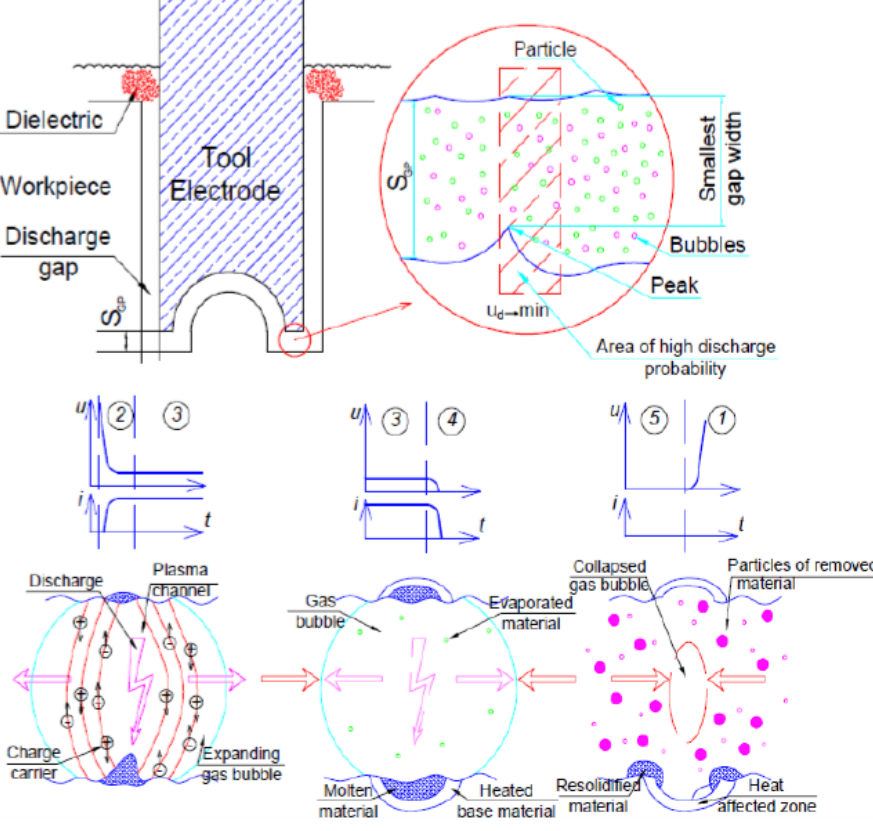
Figure 3. The pulse occurring through the electrical discharge machining